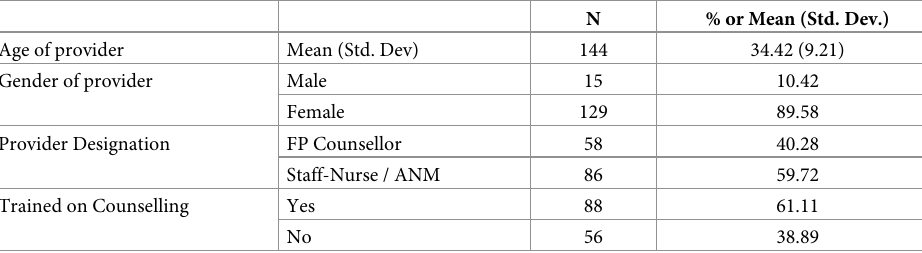
Table 2. Descriptive statistics of provider level characteristics (N = 144).